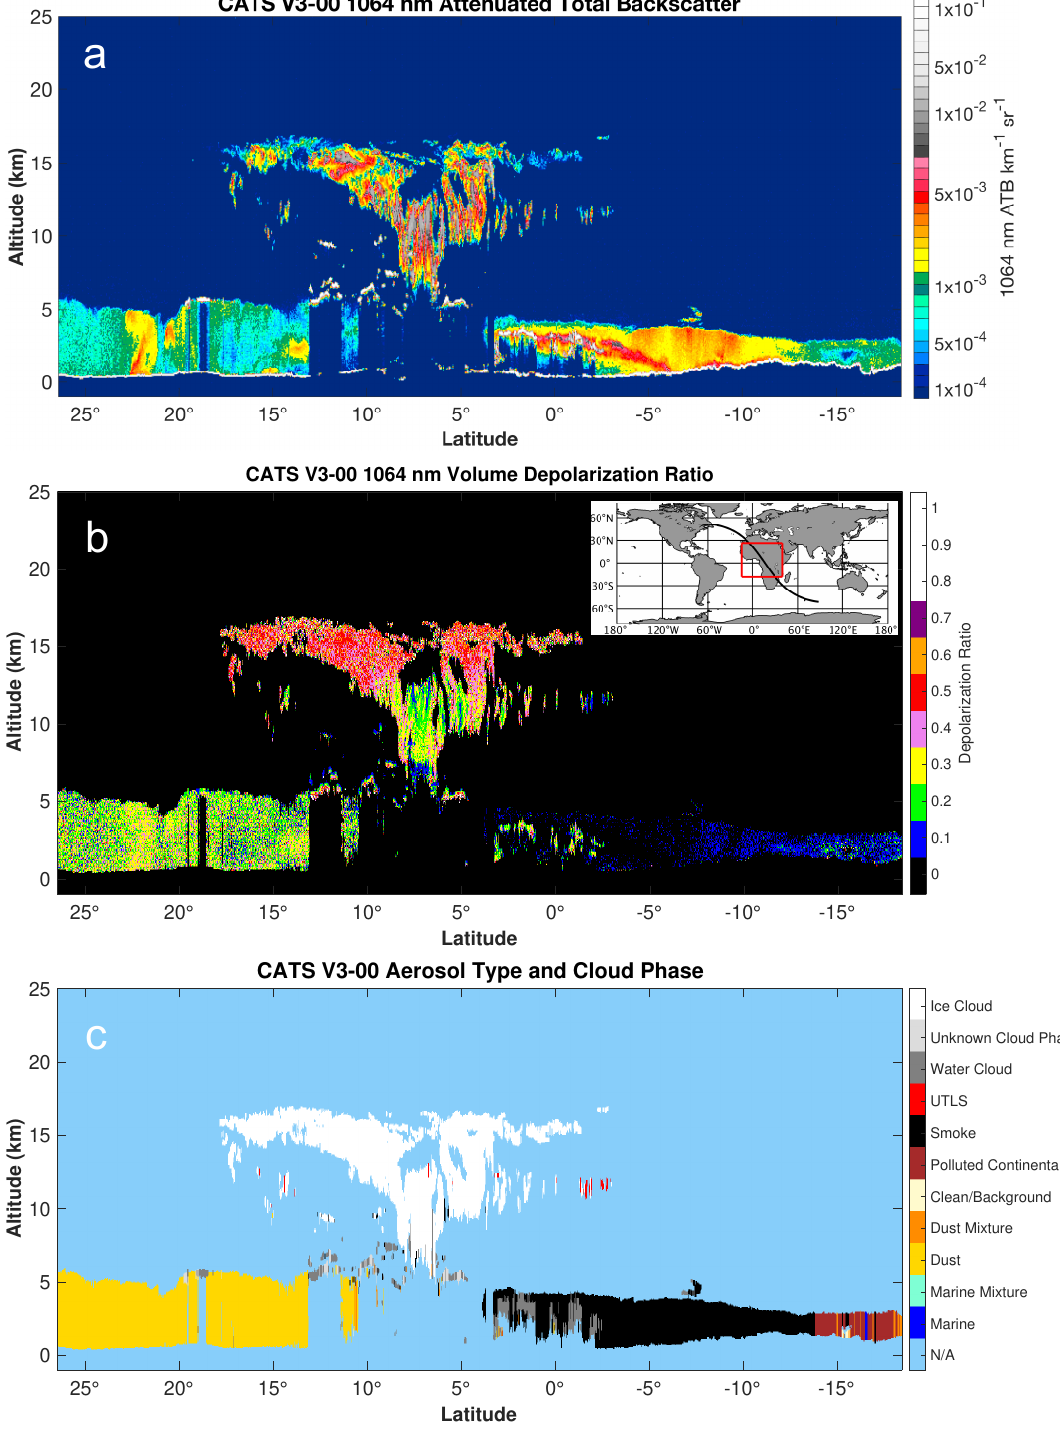
Figure 2. An example of how CATS observables and MERRA-2 aerosols were used to inform aerosol type for a subset of the CATS track (red box) on 6 August 2016. CATS 1064 nm total attenuated backscatter ( a ) and 1064 nm depolarization ratio ( b ) are used to identify features and first classify as cloud or aerosol ( c ) along with ancillary information, as described in Yorks et al., 2021 [23]. CATS observables (e.g., depolarization ratio to identify desert dust) are further used with additional ancillary information and MERRA-2 aerosols to identify aerosol type ( c